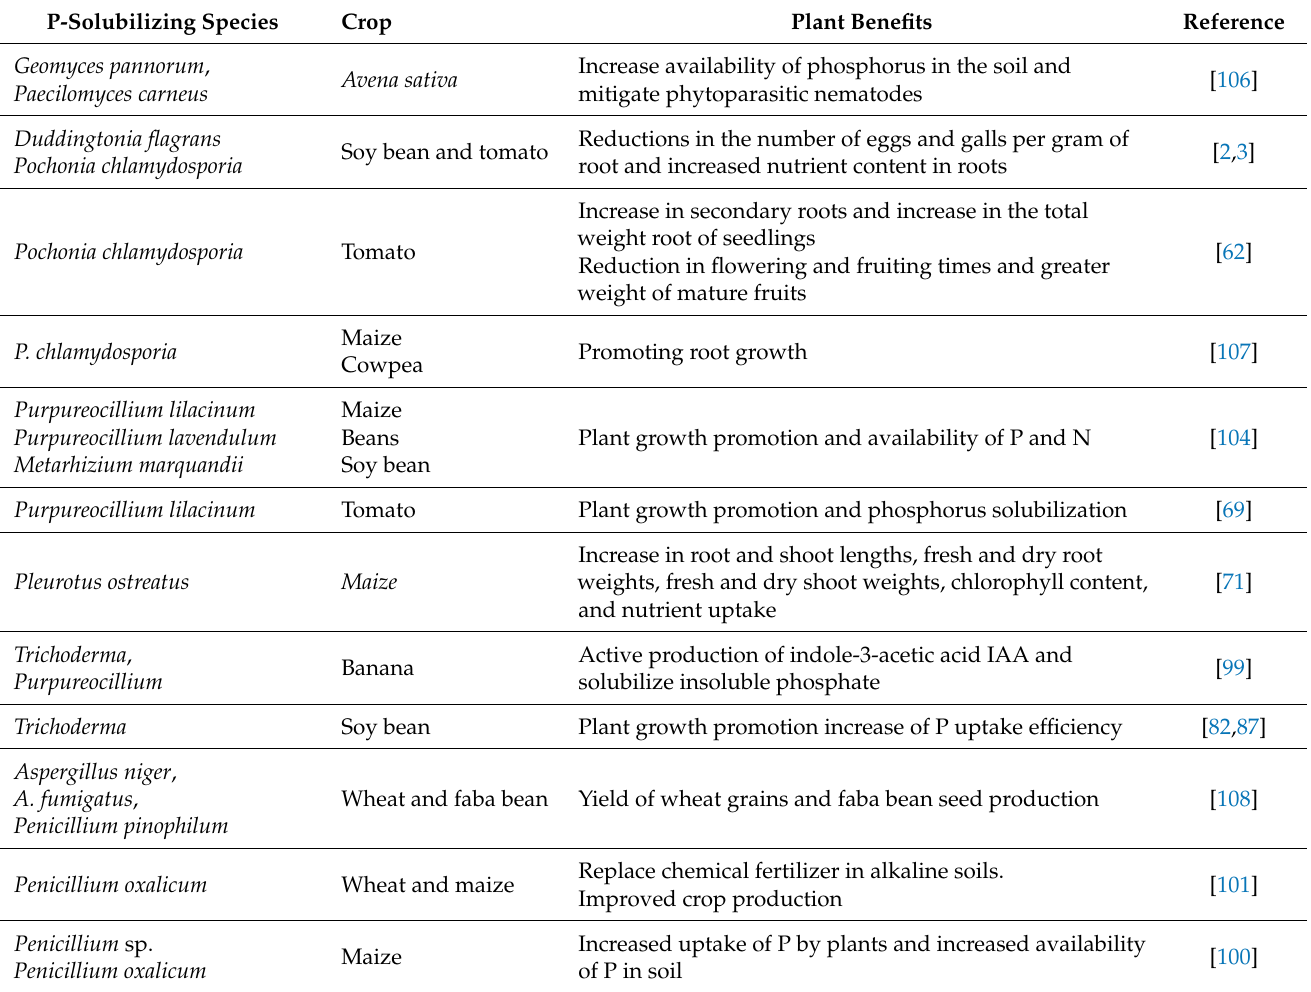
Table 2. List of P-solubilizing NF and related benefits in agricultural